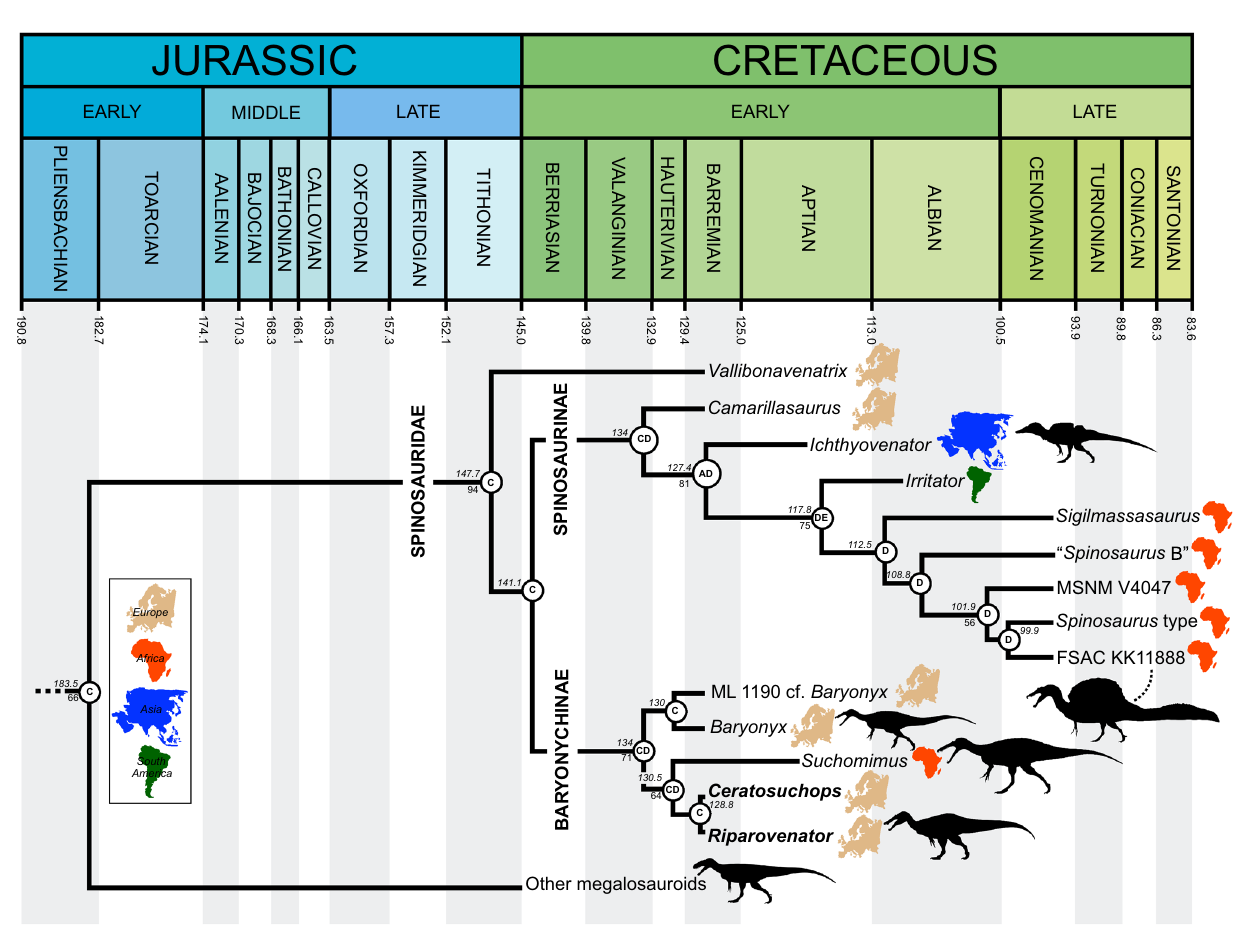
Figure 7. Time-calibrated phylogenetic relationships of Spinosauridae, based on the Maximum Clade Credibility Tree inferred by the Bayesian analysis (see SI for extended figure). Numbers at nodes represent node age (top, in million years) and posterior probability values > 50% (bottom). Letters at nodes refer to the most likely ancestral area reconstructed. Geologic timescale from Walker et al. (2018). A Asia, B North America, C Europe, D Africa, E South America. Silhouette credits: Riparovenator —Dan Folkes (CC-BY 4.0); Baryonyx , Megalosaurus , Suchomimus —Scott Hartman/Phylopic (CC-BY-NC-SA 3.0); FSAC KK 11,888—Scott Hartman; Ichthyovenator —Alex Vieira (CC-BY-NC-SA